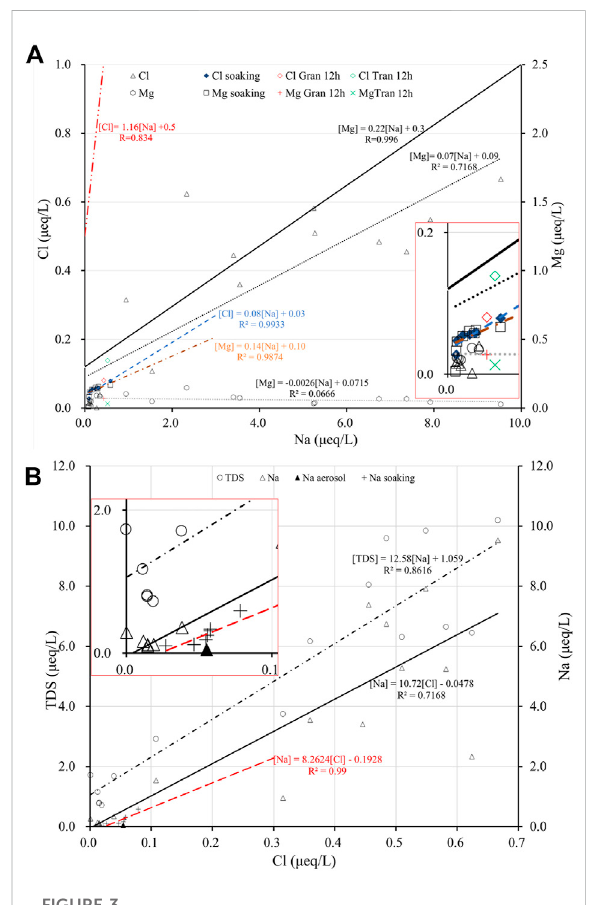
FIGURE 3 (A) Diagram of Na – Mg – Cl concentrations; the inset is at the enlarged leftbottomcorner; reddashed pointand blacksolidlines stand for marine precipitation data from Keene et al. (1986); blue- dashed and brown-dashed point lines for solutions of soaking granodiorite grains for 168 h, which were extended for comparison, and two points for data of soaking 2,000- μ m grains ofgranodiorite(Gran)andtrachyandesite(Tran)undertheambient conditionfor12 h(Duetal.,2010);pointlinesfordataofthisstudy. (B) Diagram of Na-TDS-Cl; the inset is at the enlarged left bottom corner; the short extended dashed line for data of solutions of soaking granodiorite grains of different sizes under the ambient condition for 168 h (Du et al.,